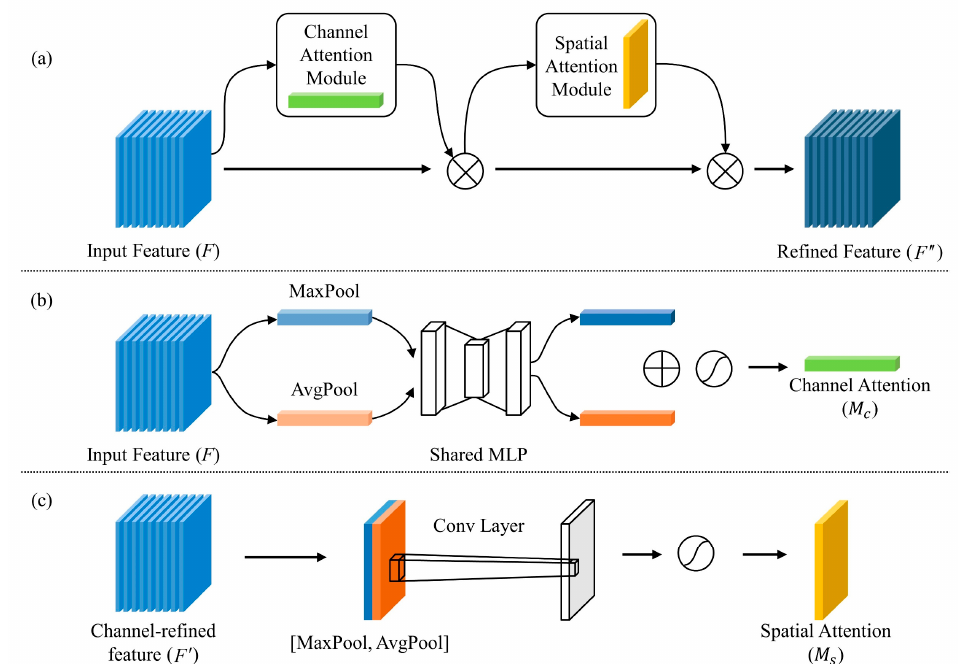
Figure 3. The architecture of convolutional block attention module. ( a ) The convolutional block attention module. ( b ) The architecture of channel attention. ( c ) The architecture of spatial attention. Reproduced with permission from Ref. [34]. Copyright 2021